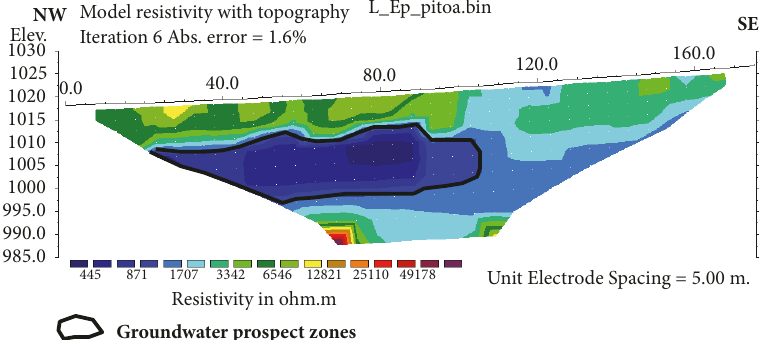
Figure 9: Inverse resistivity model along profile 6.